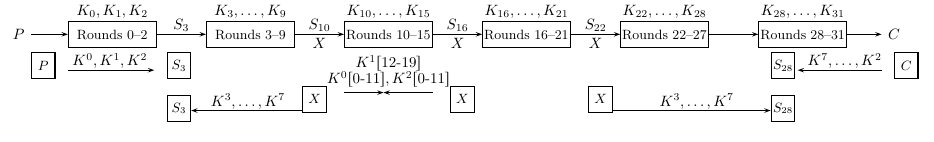
Figure 3: A schematic description of the fixed-point